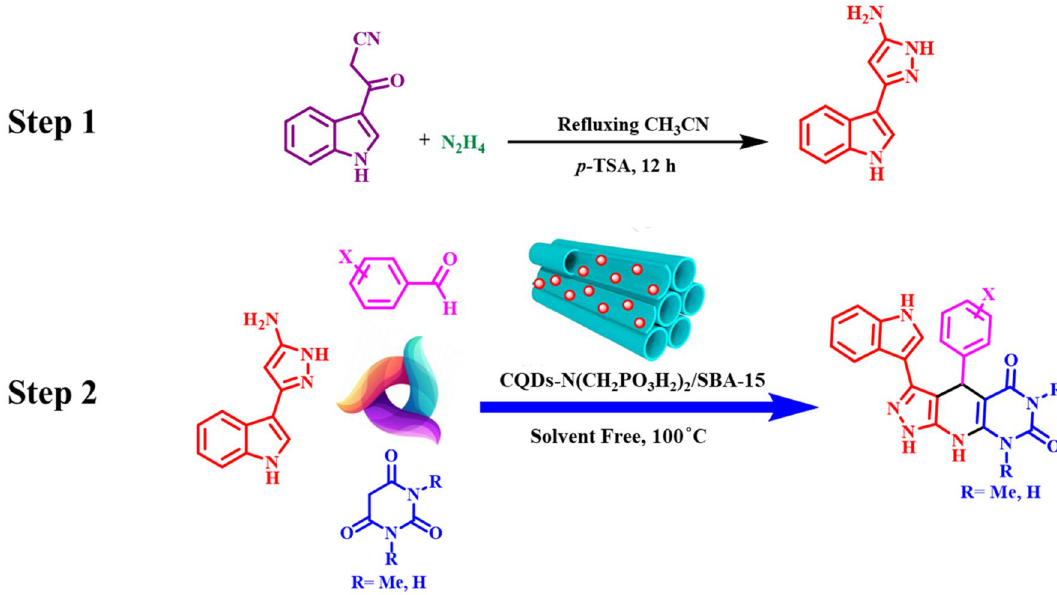
Figure 2. Synthesis of pyrazolo[4 ′ ,3 ′ :5,6]pyrido[2,3- d ]pyrimidine derivatives using CQDs-N(CH 2 PO 3 H 2 ) 2 / SBA-15.